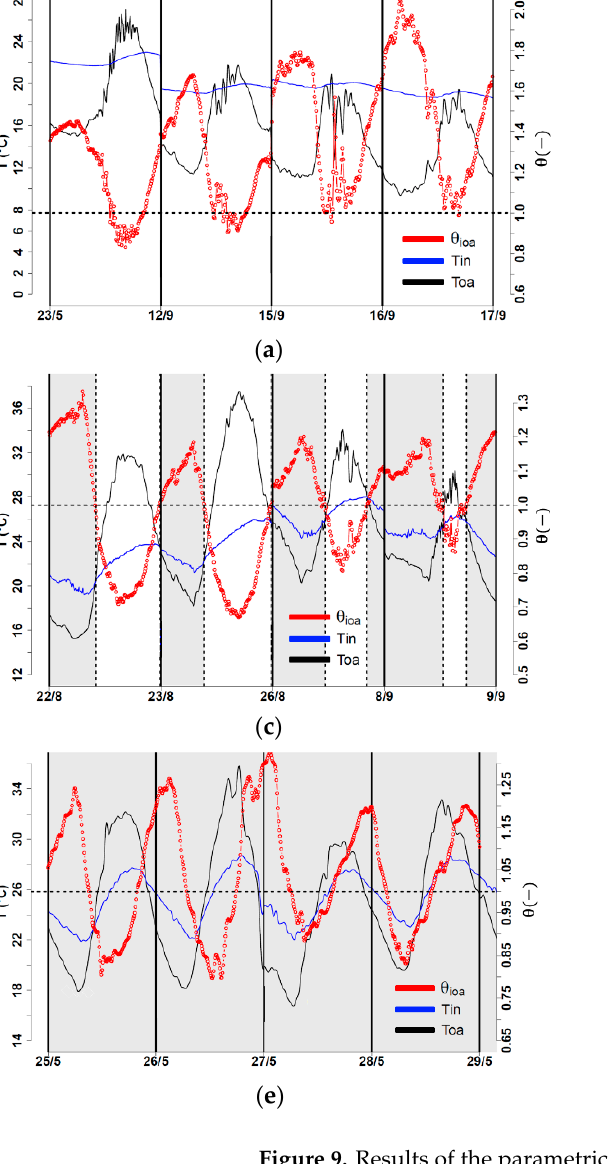
Figure 9. Results of the parametric analysis from temperature measurements for: Config. #1 ( a ) and ( b ), config. #2 ( c ) and ( d ), and config. #3 ( f ) and ( g ).